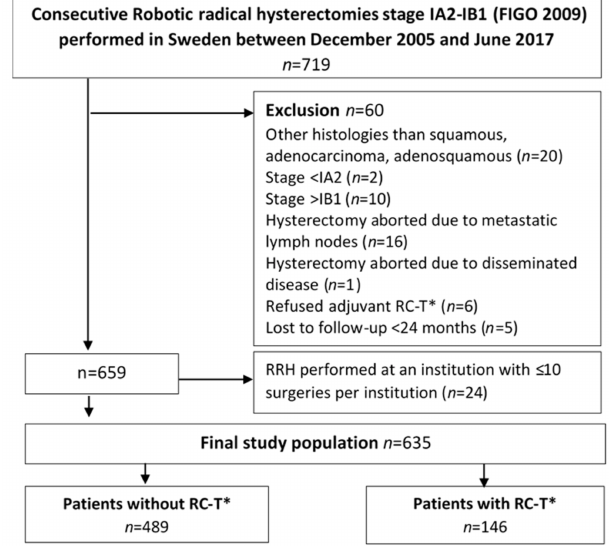
Figure 2. Strobe flow chart for all women in Sweden with stage IA2-IB1 squamous, adenocarcinoma or adenosquamous cervical cancer operated by robotic radical hysterectomy between December 2005 and June 2017 evaluating the impact of surgical experience on the rate of recurrence and postoperative complications. Sub-legend: * Oncologic protocol violations = women unwilling to receive recommended postoperative